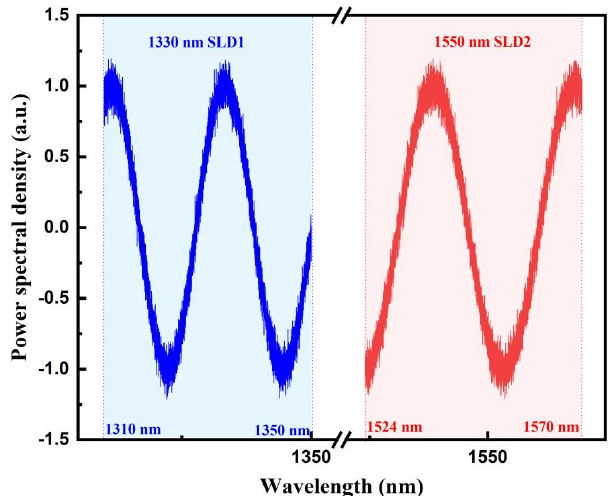
Figure 4. Simulated reflection spectrum of a 40 μ m fiber-optic F–P sensor under the illumination of two SLDs with different central wavelengths including random noise.